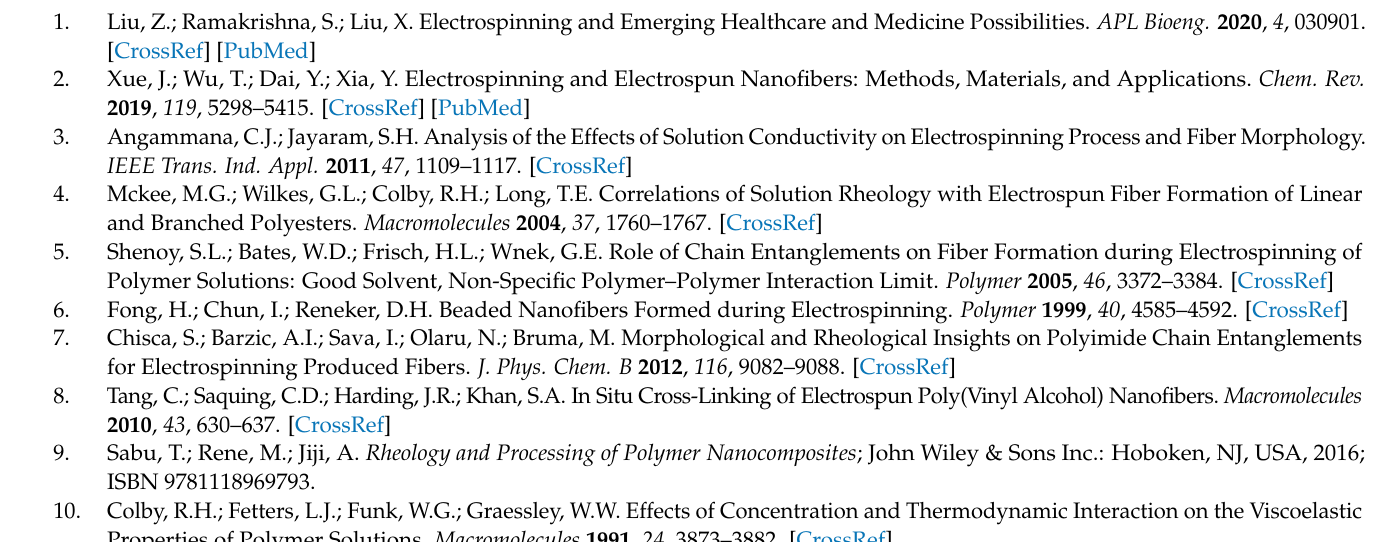
conductivity results with p -values investigated. Table S2: Statistical analysis of solution surface tension results with p -values investigated. Table S3: Statistical analysis of diameter of electrospun nanofibers with p -values investigated. Reference [59] is cited in the Supplementary